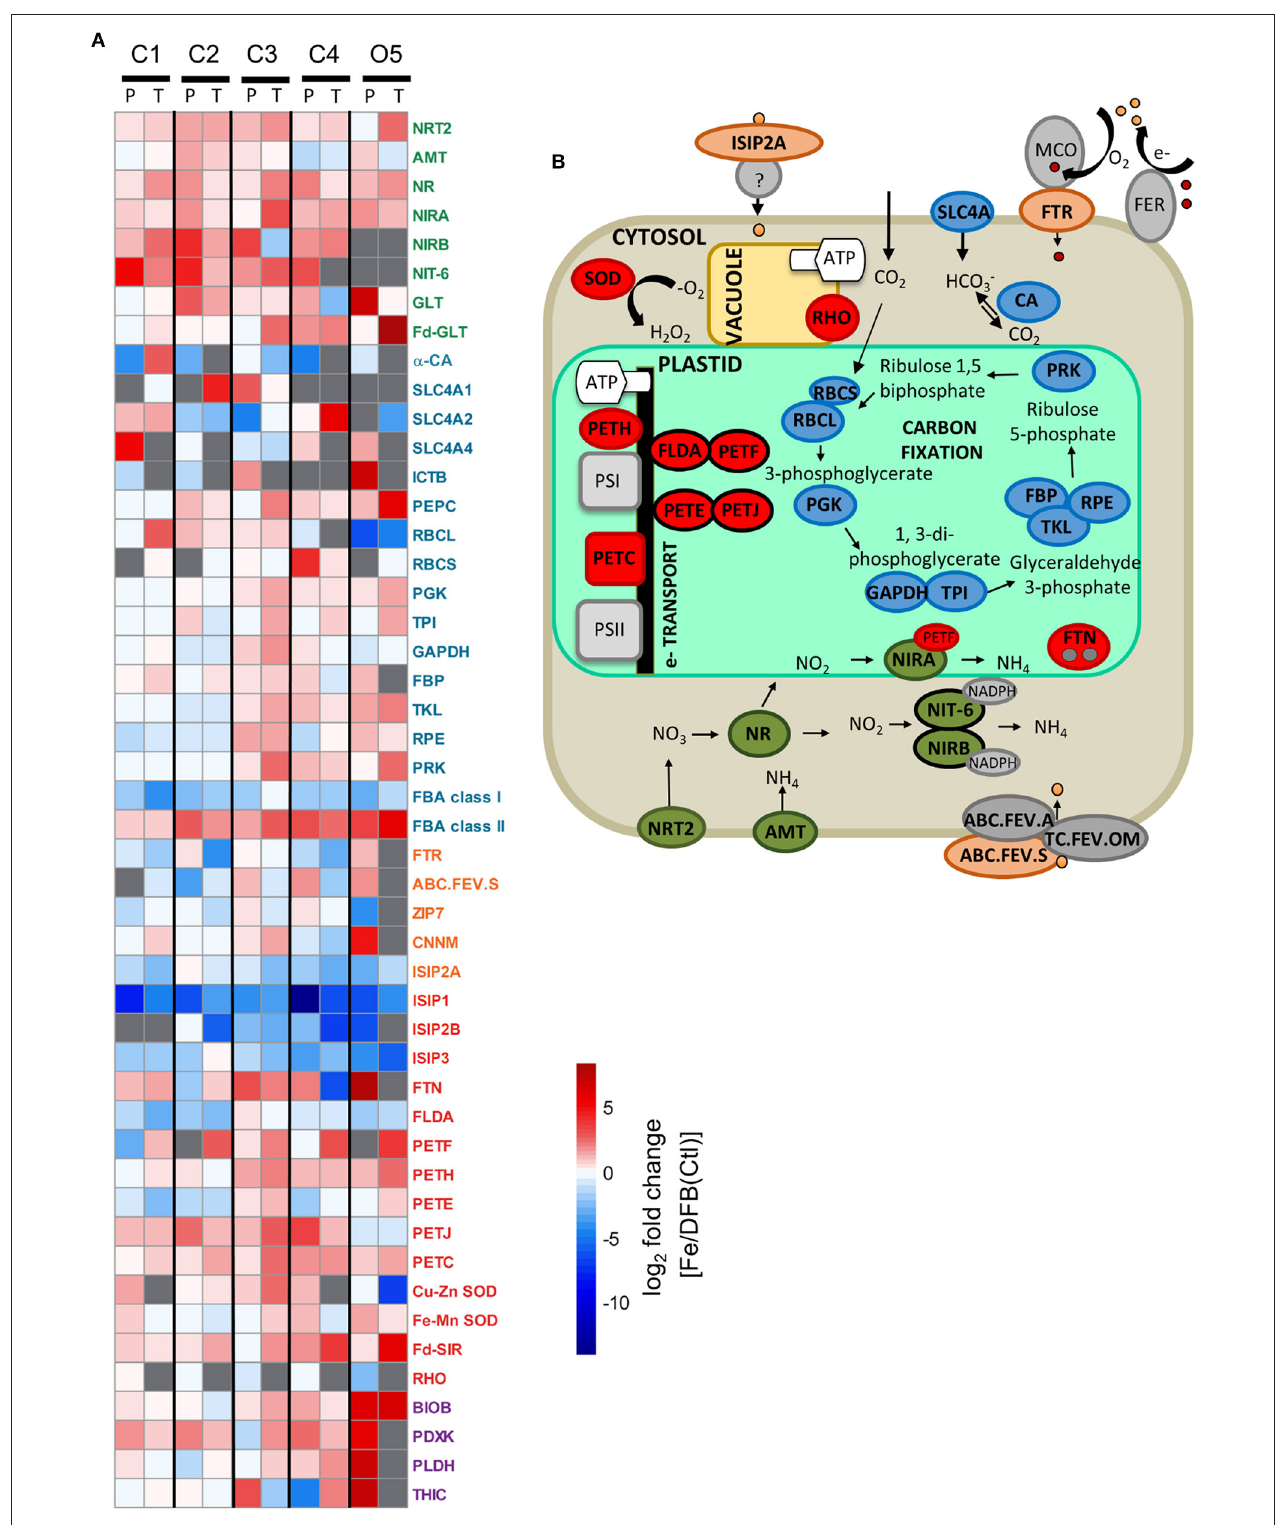
FIGURE 5 | Differential expression responses of select genes involved in nitrogen (N; green), carbon (C; blue), metal transport (orange), iron (Fe; red), and vitamin (purple)-related processes between the T 1 Fe and DFB/Ctl treatments within the diatom genera Pseudo-nitzschia (P) and Thalassiosira (T) (A) . Heatmap